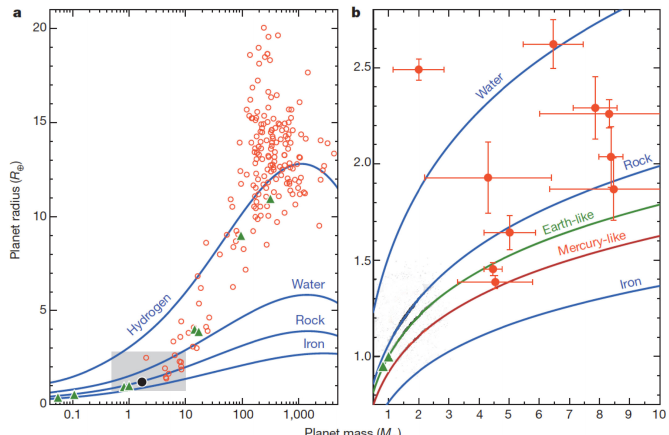
Figure 25. Mass-radius relationship for the well-characterized exoplanets; adapted from Reference [66]. Solar system planets are marked by triangles. ( a ): massive exoplanets are similar in composition to the solar system’s gaseous giants. ( b ): zoom to masses and radii similar to that of the Earth. Both panels illustrate that the solar system’s terrestrial planets are more enriched with heavy elements than exoplanets. (Continuous data updates are available at NASA Exoplanet Archive [267] and provided images demonstrate the same trends.) The graphs also illustrate a degeneracy in that exoplanets of different masses and compositions can have similar